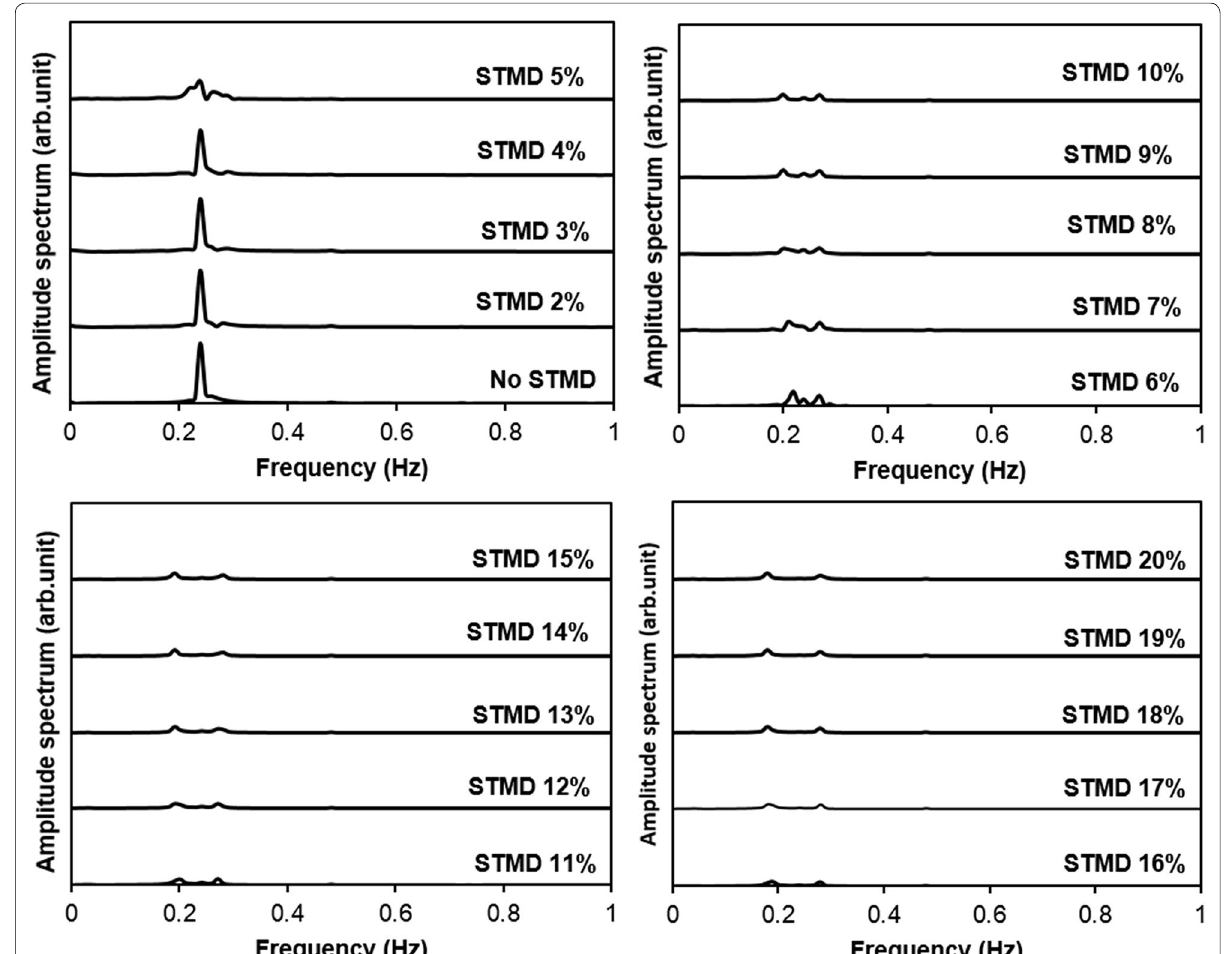
Fig. 14 Passive mode response of the buoy in frequency-domain. Buoy’s pitch deviation with the STMD with mass ratios of 2% to 20% in a passive mode control is presented in frequency